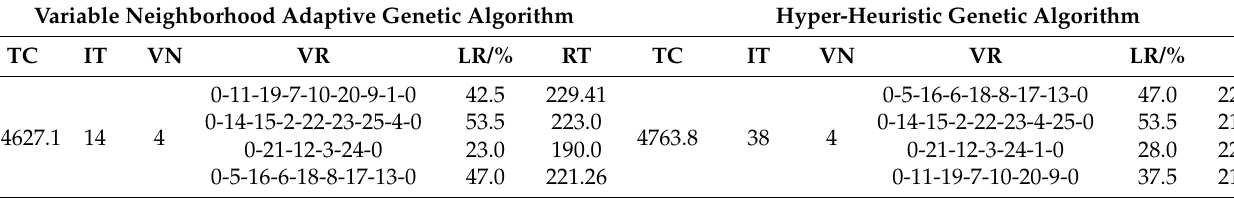
Table 1. Comparison of experimental results in VRPSTW model. Variable Neighborhood Adaptive Genetic Algorithm Hyper-Heuristic Genetic